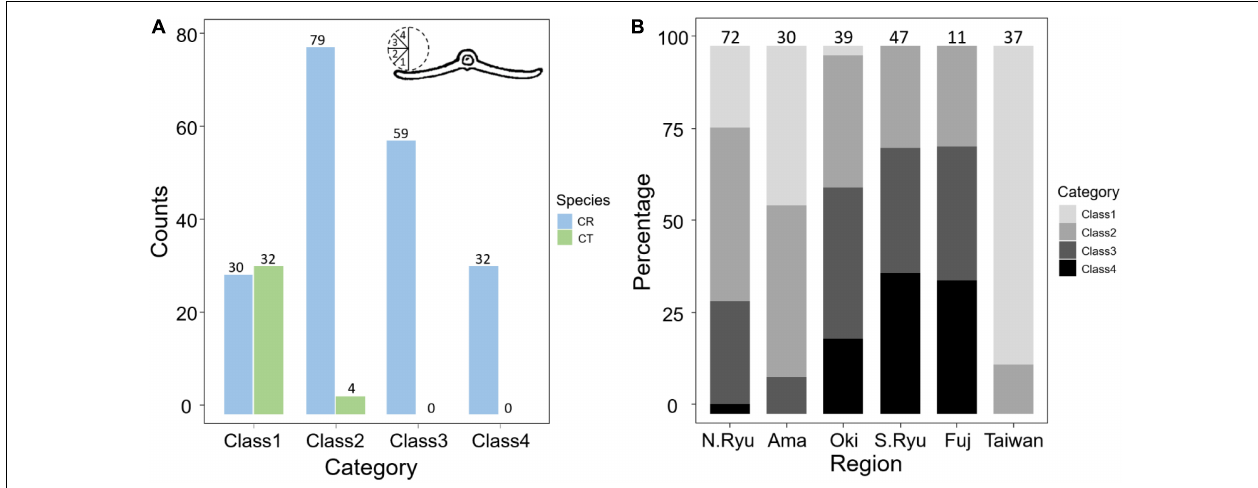
FIGURE 5 | Comparisons of the revolute extent in the leaflet margin (A) between species and (B) among geological regions. The number above the bars are measured sample size. CR, Cycas revoluta ; CT, Cycas taitungensis . The cross section of leaflet is modified from Li and Keng (1975).